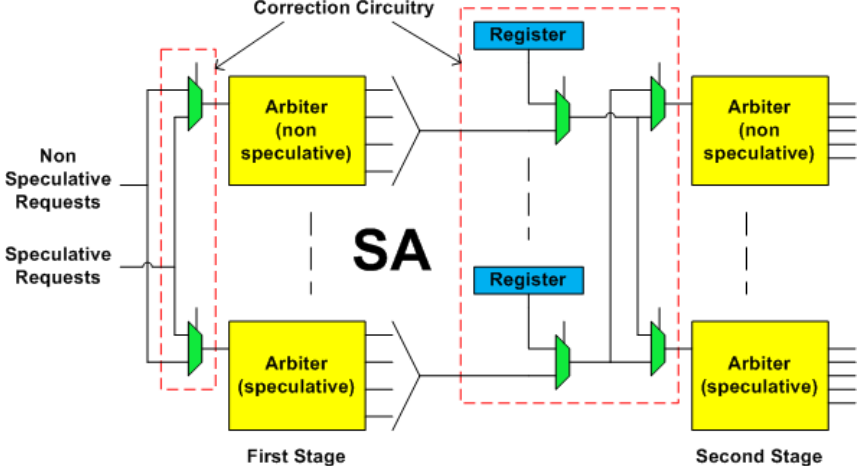
Figure 7. Fault-Tolerant SA Unit